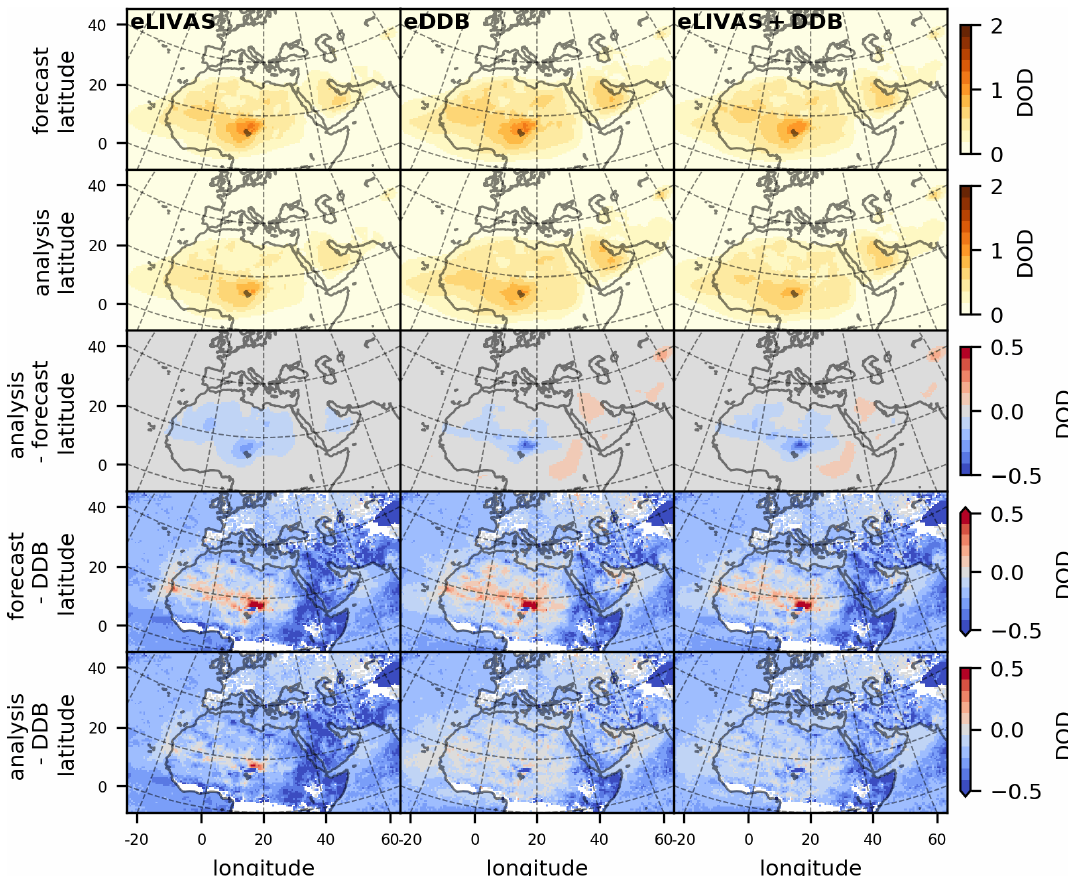
Figure 3. Averaged DOD from the experiments and differences with the DDB DOD during the whole study period. Experiments listed in Sect. 2.5 are represented in columns. The first and second rows show the average DOD for the forecast and analysis experiments respectively. The third row shows the difference between average analyses and forecasts. Collocated differences between the forecasts and the DDB DOD averages are shown in the fourth row. The last row shows the difference between the analyses and the DDB DOD